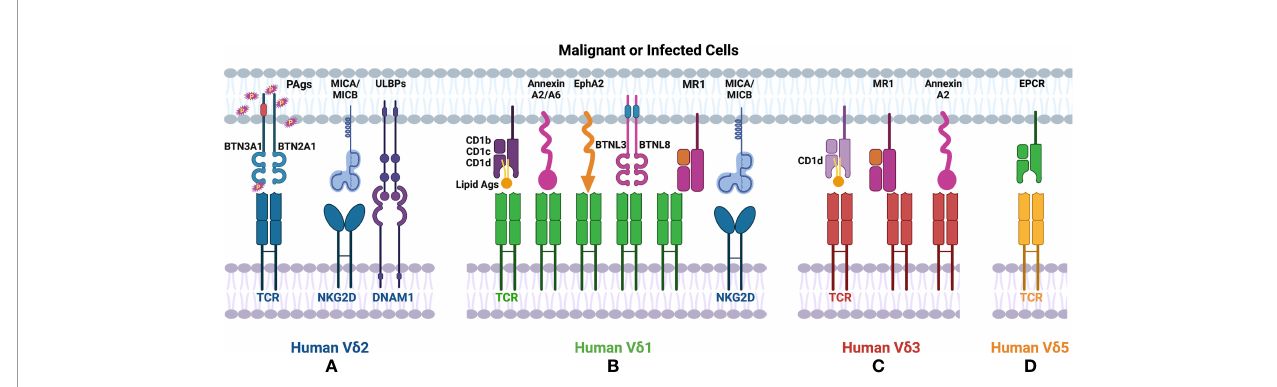
FIGURE 1 | Ligands recognized by human gd T cells. (A) Human V d 2 T cells recognize PAgs via TCR in a BTN molecule dependent manner. (B) TCRs of human V d 1 cells recognize lipid antigens presented by CD1. Human V d 1 also binds to Annexin A2/A6, EphA2, MR1 in an antigen-independent manner. (A, B) Both human V d 1 and V d 2 T cells express NKRs (such as NKG2D, DNAM1), which bind to MICA/MICB, ULBPs expressed on tumor cells. (C) Human V d 3 cells interact with CD1d with/without antigen via TCR, also recognize Annexin A2 or MR1 without antigen loading. (D) Human Vd5 cells bind to EPCR via